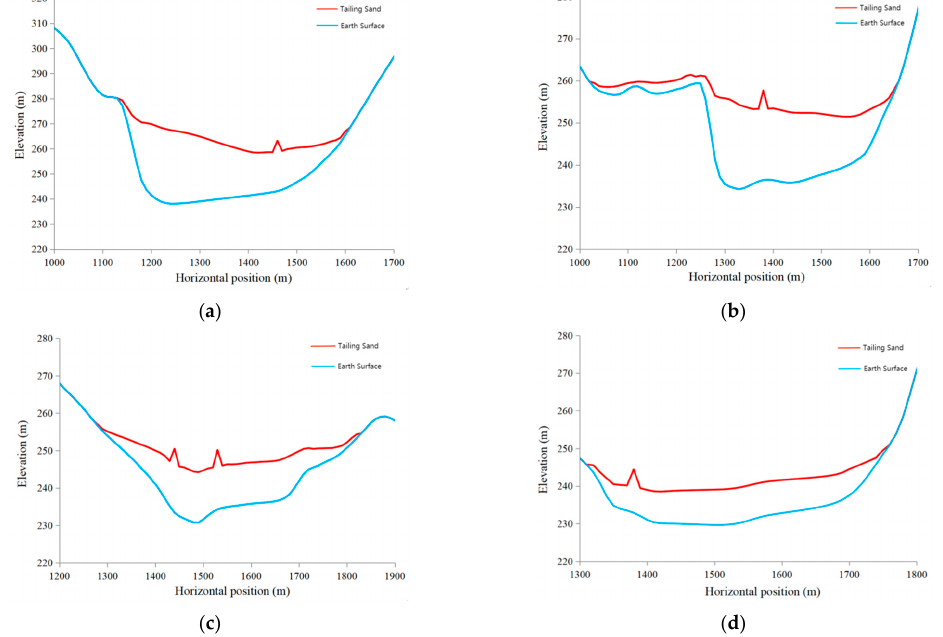
Figure 12. Tailing sand accumulation pattern at each monitoring section. ( a ) MS1 monitoring cross-section; ( b ) MS2 monitoring cross-section; ( c ) MS3 monitoring cross-section; ( d ) MS4 monitoring cross-section.